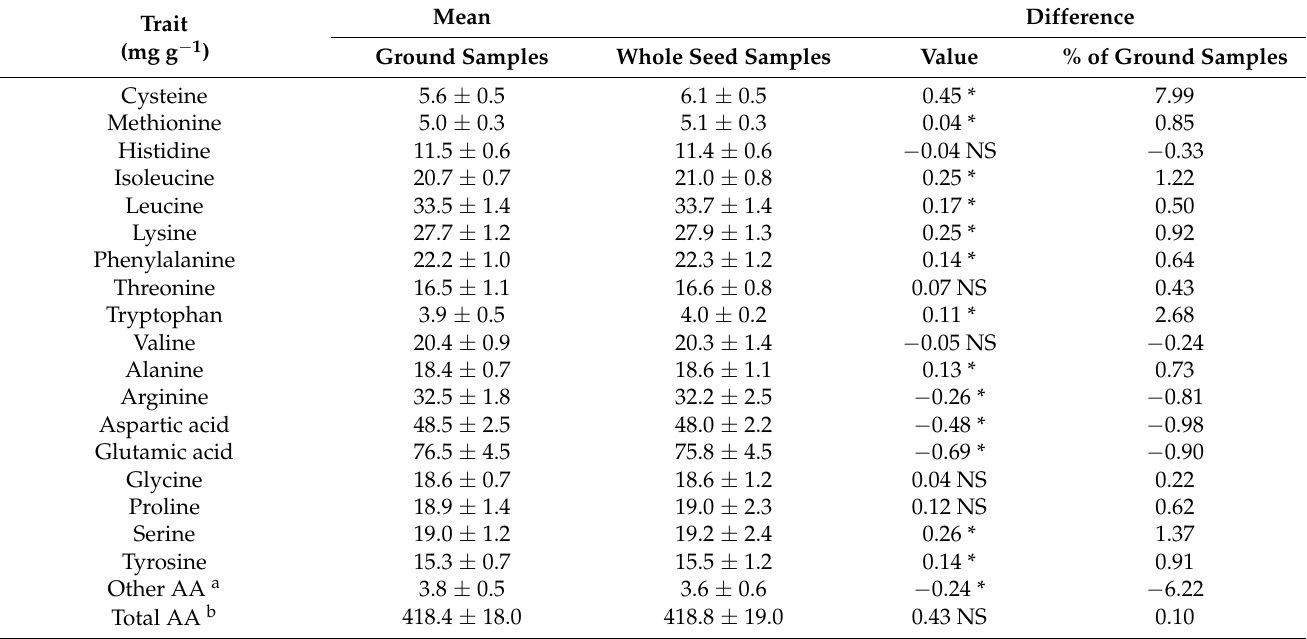
Table 2. Means ( ± SD) and differences of seed amino acids for ground and whole seeds of edamame all over three drying methods and three years (2018–2020).